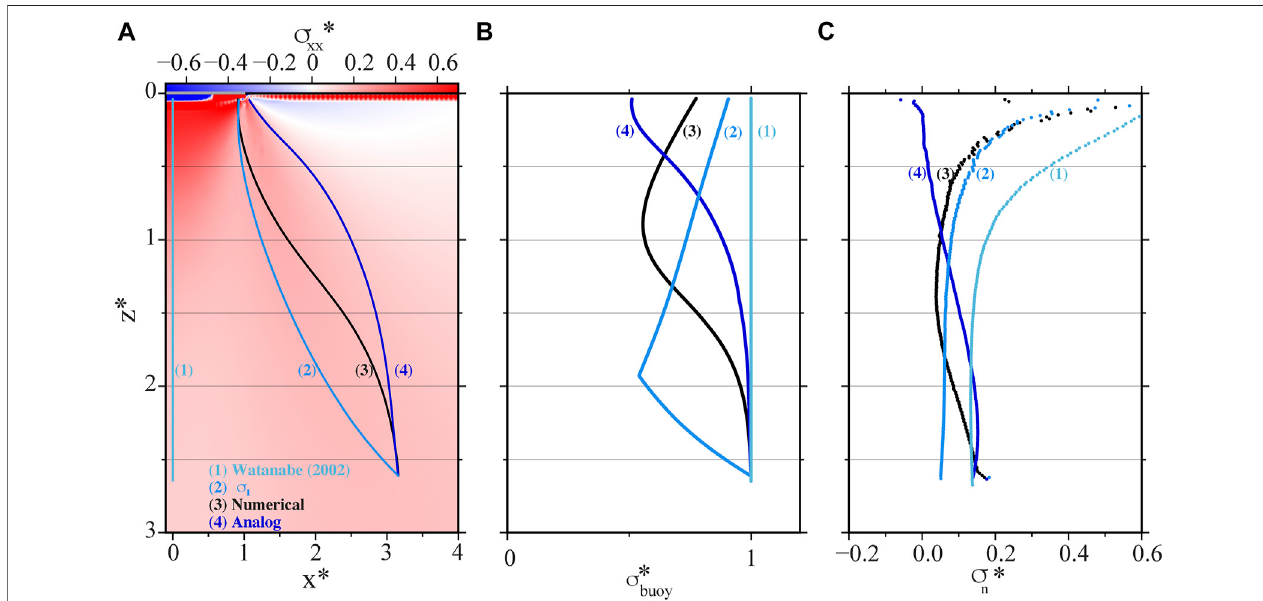
FIGURE 4 | Numerical analysis of de fl ected air- fi lled crack for experiment EXP61 and for the vertical rising oil- fi lled crack described by Watanabe et al. (2002). (A) Various trajectories represented superimposed on the horizontalcomponent ( σ xx * ) of the stress fi eld perturbation induced by the load applied at the surface: 1) is for the verticalpathoftheexperimentperformedbyWatanabeetal.(2002),trajectories2),3)and4)allinitiateatthestartingpositionofexperimentEXP61,2)beingtangentialto the maximum compressive stress σ 1 , 3) being the numerical path derived from the BE model and 4) being the experimental path recorded. The grey line at z * = 0 is for the position of the applied load. (B) Evolution of the relative buoyancy of the crack along various trajectories compared to the buoyancy of a vertical crack ( σ buoy * (cid:1) L z / L , with L the experimental crack length). This relative buoyancy is maximum and equal to 1 when the crack is vertically oriented and decreases with the inclination of the trajectory. (C) Evolution along various trajectories of the normal component of the external stress fi eld induced by the load and acting perpendicular to the crack opening direction. Stresses are normalized by the pressure applied at the surface, compression is positive while tension is negative. Vertical and lateral dimensions are normalized by the half-length of the load applied at the surface.